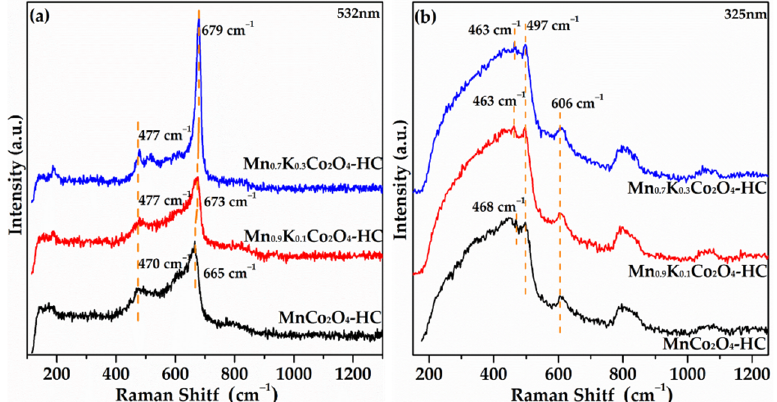
Figure 7. Raman spectra of as-prepared monolith catalysts under different laser wavelength of 532 nm ( a ) and 325 nm ( b ). 532 nm ( a ) and 325 nm ( b